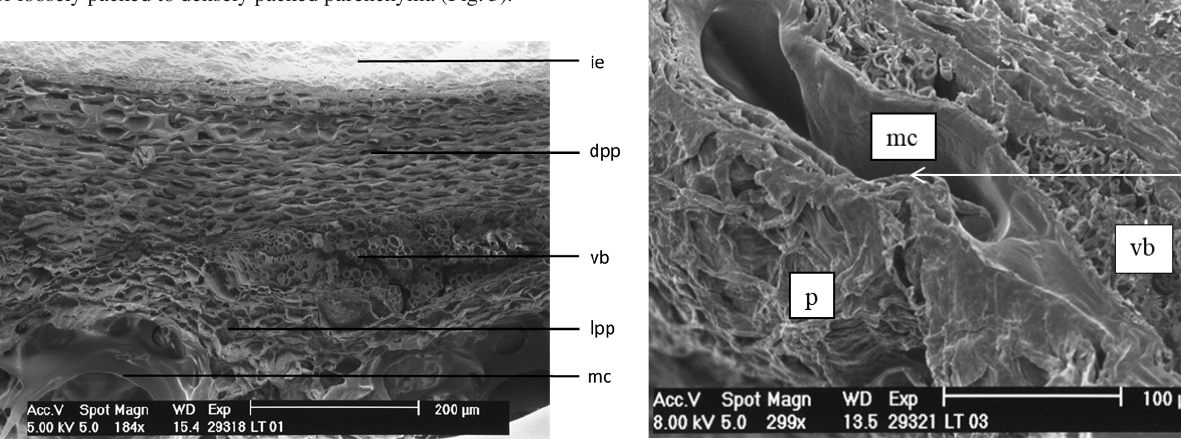
Fig. 7: SEM image of a mucilage cavern, p = fruit pulp located outside the testa directly attached to the outer epidermis (oe) of the exotesta, pulp cells are desiccated and dried by preparation during lyophi- lization, mc = mucilage cavern, vb = vascular bundle. Parenchyma tissues are adjacent to the outer epidermis. The endotesta (en) is not seen in this